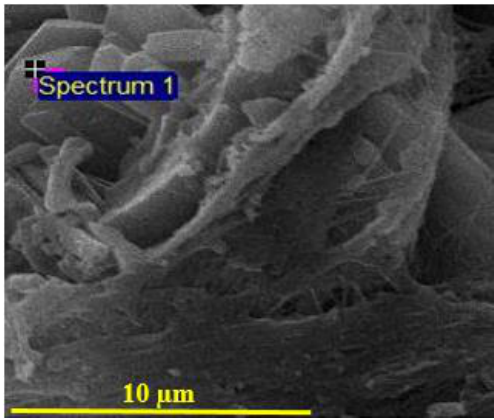
Figure 1. Scanning electron microscopic image of wet blue leather (before chromium removal)